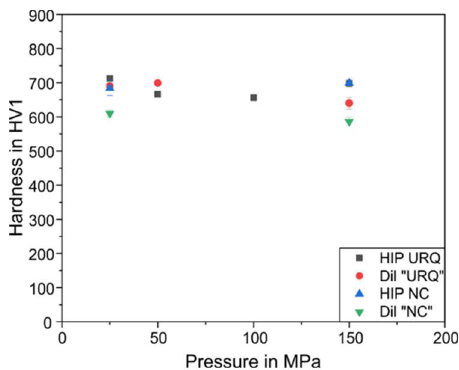
Figure 7. Results of hardness tests (HV1) of X37CrMoV5-1 wire material heat treated under different process pressures and corresponding cooling rates inside a HIP. For comparison, hardness values of wire bundles similarly heat treated in a quenching dilatometer under ambient pressure are denominated as (DIL “URQ”) and (DIL “NC”).